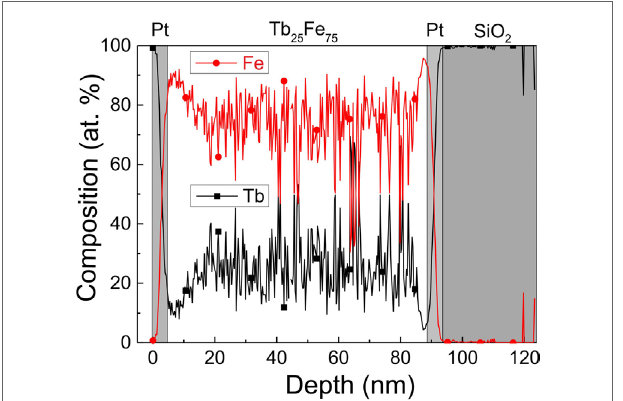
FigUre 5 | siMs composition depth profile of the following layer stack: Pt(5 nm)/Tb 25 Fe 75 (85 nm)/Pt(5 nm)/siO 2 (100 nm)/si(100) substrate .